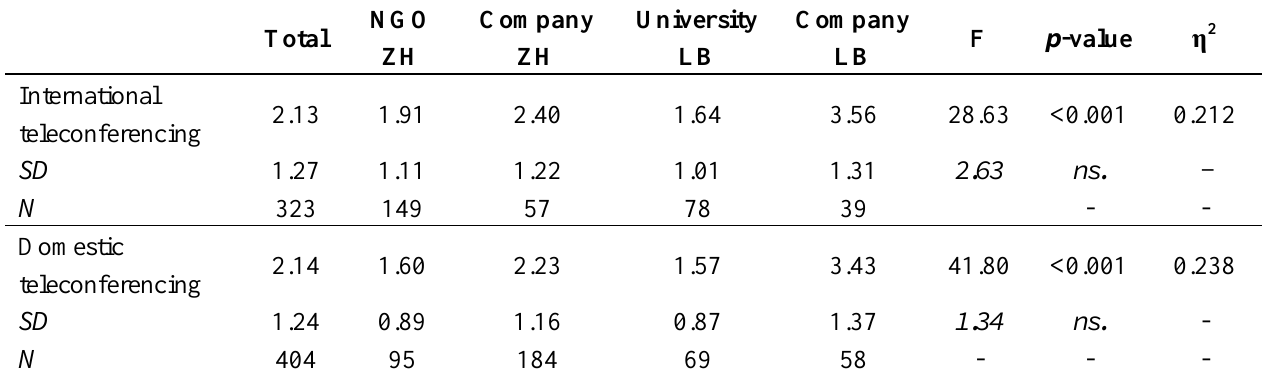
Table 2. Means, SDs, and sample size of behaviors by